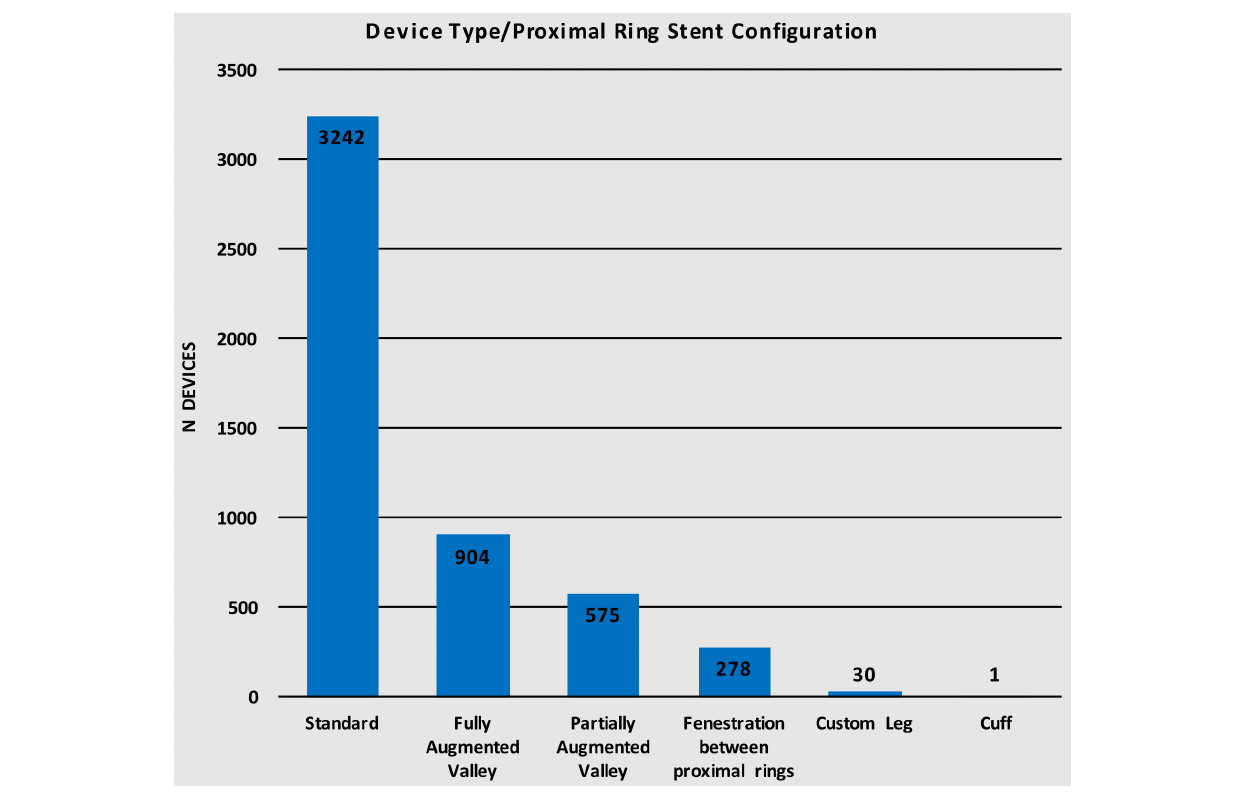
FIGURE 4 | Device type/proximal ring stent configuration.